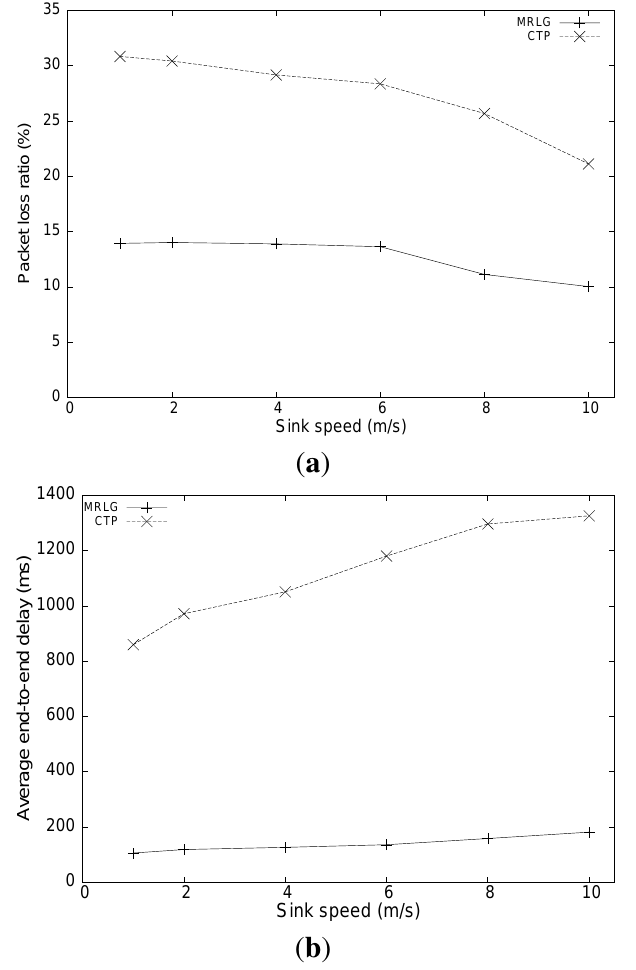
Figure 12. Varying the sink speed: ( a ) packet loss ratio, ( b ) end-to-end